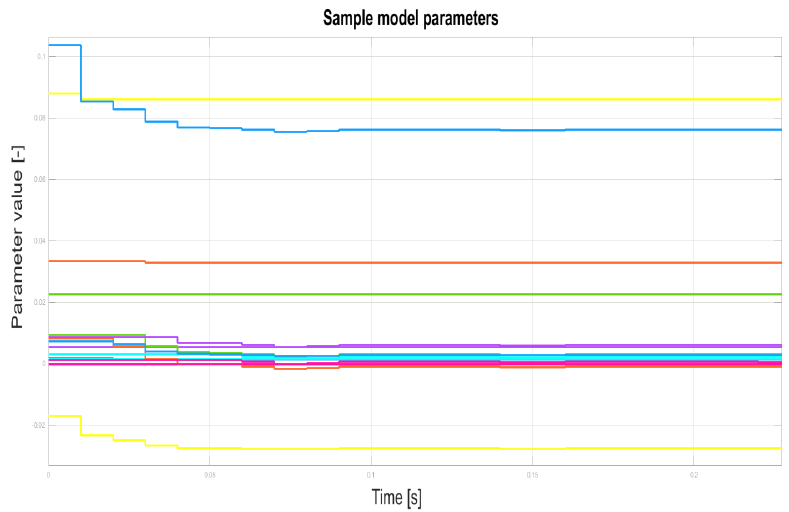
Figure 6. Model parameters estimated using